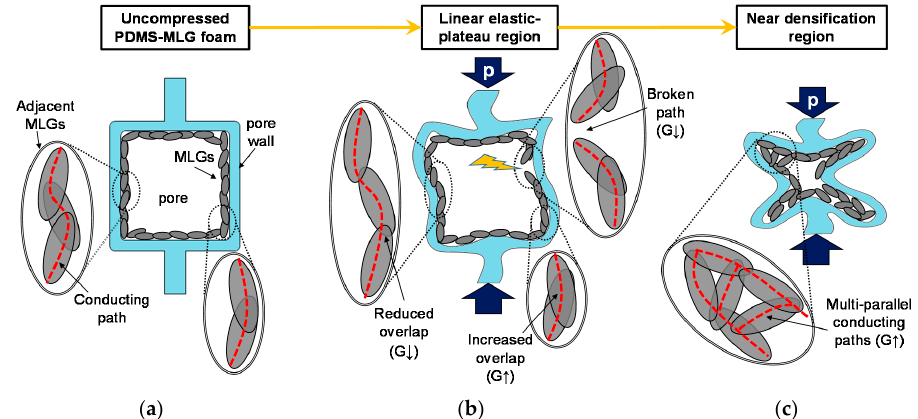
Figure 17. MLG coating modification during compression and its effect on the overall conductance G of the foam. ( a ) Before loading, MLGs adhere to the PDMS foam walls and create the conducting paths that affect the value of the foam initial conductance G 0 ; ( b ) Applying a pressure in the linear-plateau region of the foam response, the MLG coating undergoes modification due to the sliding between flakes and due to the conducting path degradation occurring especially at higher crosshead speeds; ( c ) In proximity of the densification region of the foam, at higher pressures, the collapsing cells cause the formation of additional parallel conducting paths and the increase of G . Without an applied pressure (Figure 17a), the MLGs-coating adheres and mimics the PDMS foam inner structure, as also seen in the SEM images. At the lowest investigated strain rate, in the linear elastic and plateau regions, G is practically constant. This means that the overall electrical resistance of conductive paths created by the MLGs remains almost unchanged. In fact, during loading, some parts of the foam walls are subjected to compressive stress while others to stretching. Therefore, adjacent MLGs adhering to the PDMS skeleton surface are induced either to increase or decrease their overlapping area (if in contact, otherwise reduce or increase their mutual distances) (Figure 17b). We can speculate that this behavior is possible thanks to the MLGs good adhesion with